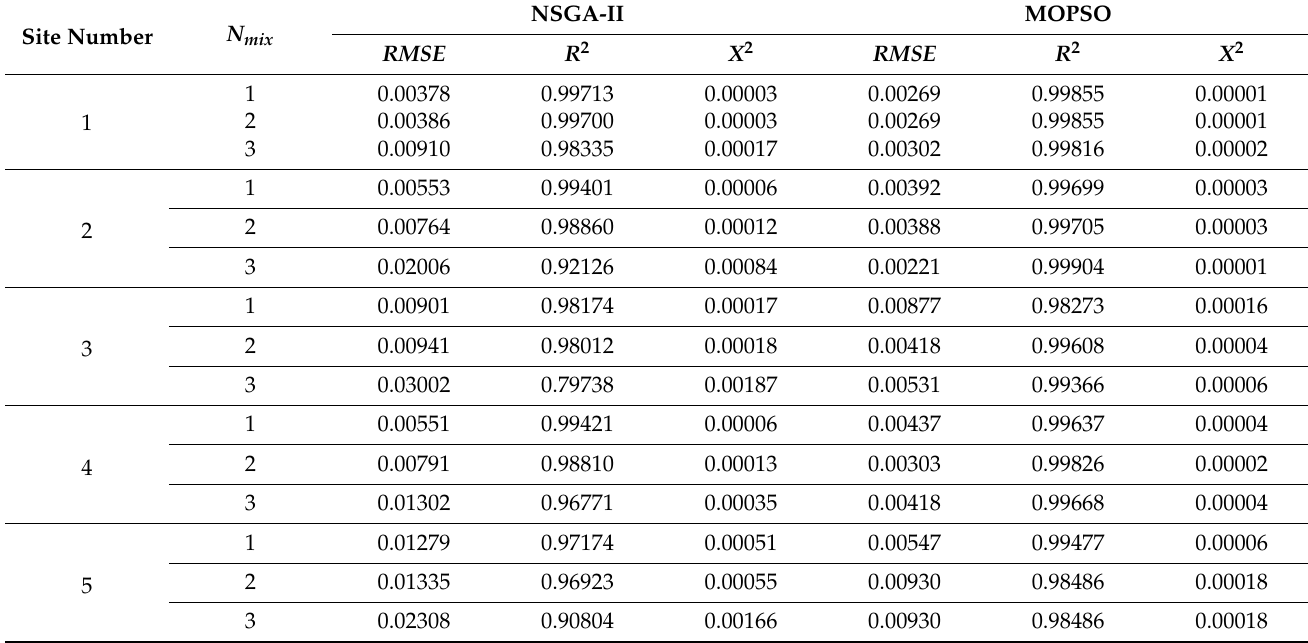
Table 3. Results obtained for 20 equal wind speed spacings in the five Egyptian sites.